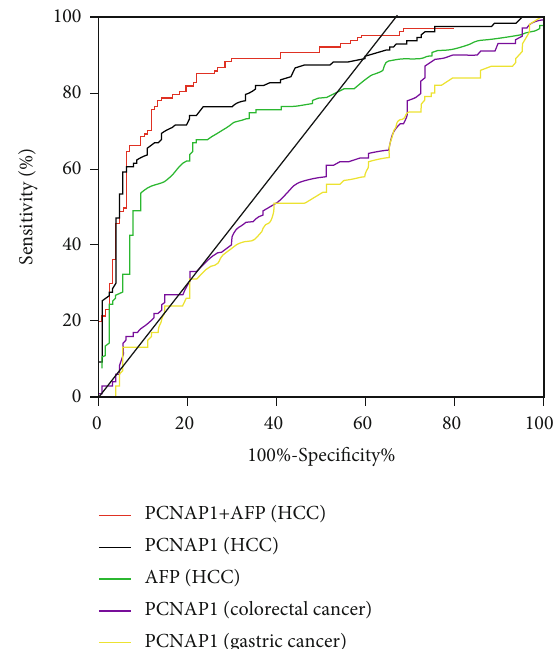
Figure 4: ROC curve analysis of the use of plasma PCNAP1 for diagnosis and di ff erential diagnosis of hepatocellular